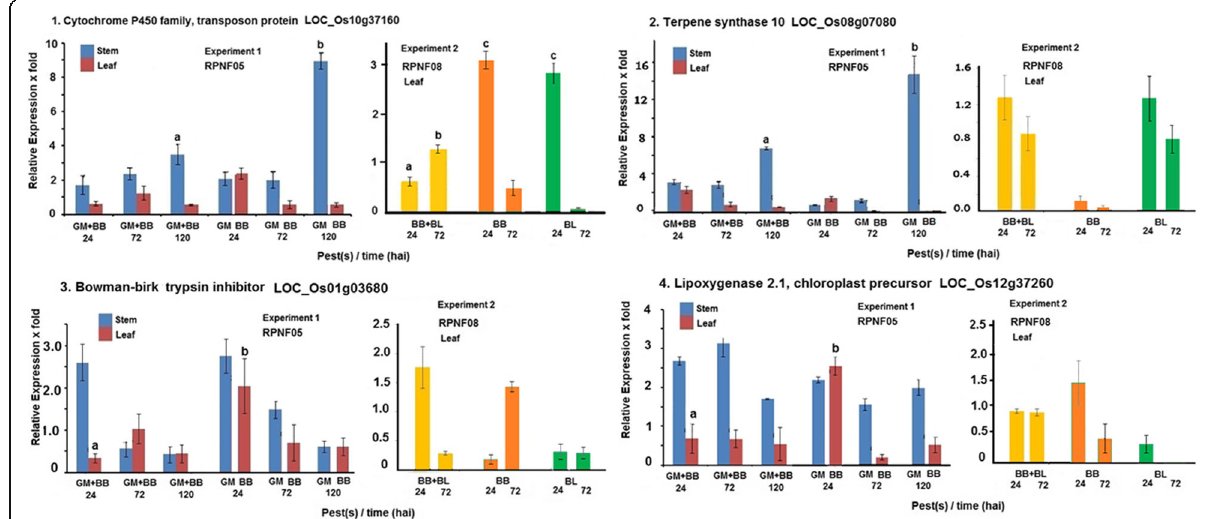
Fig. 1 Relative levels of expression of the selected four defense related gene in rice line RPNF05 following challenge by BB and/or GM (Experiment 1) or in RPNF08 following BB and/or BL infection (Experiment 2). Columns (means ± SE) with different letter are significantly different (paired t test, P <0.05)